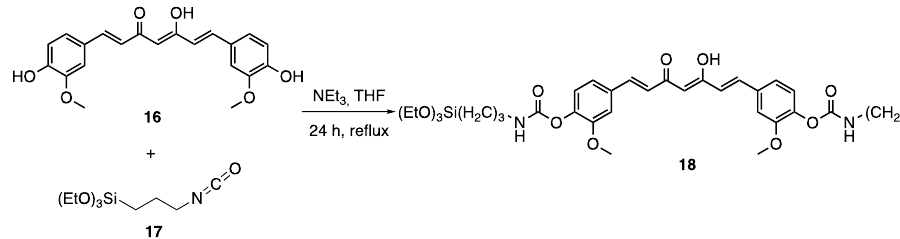
Scheme 6. Reaction of curcumin 16 and 3-(triethoxysilyl)propyl isocyanate (TESPIC) 17 to form cur- cumin-based organoalkoxysilane 18 under anhydrous basic conditions [41].